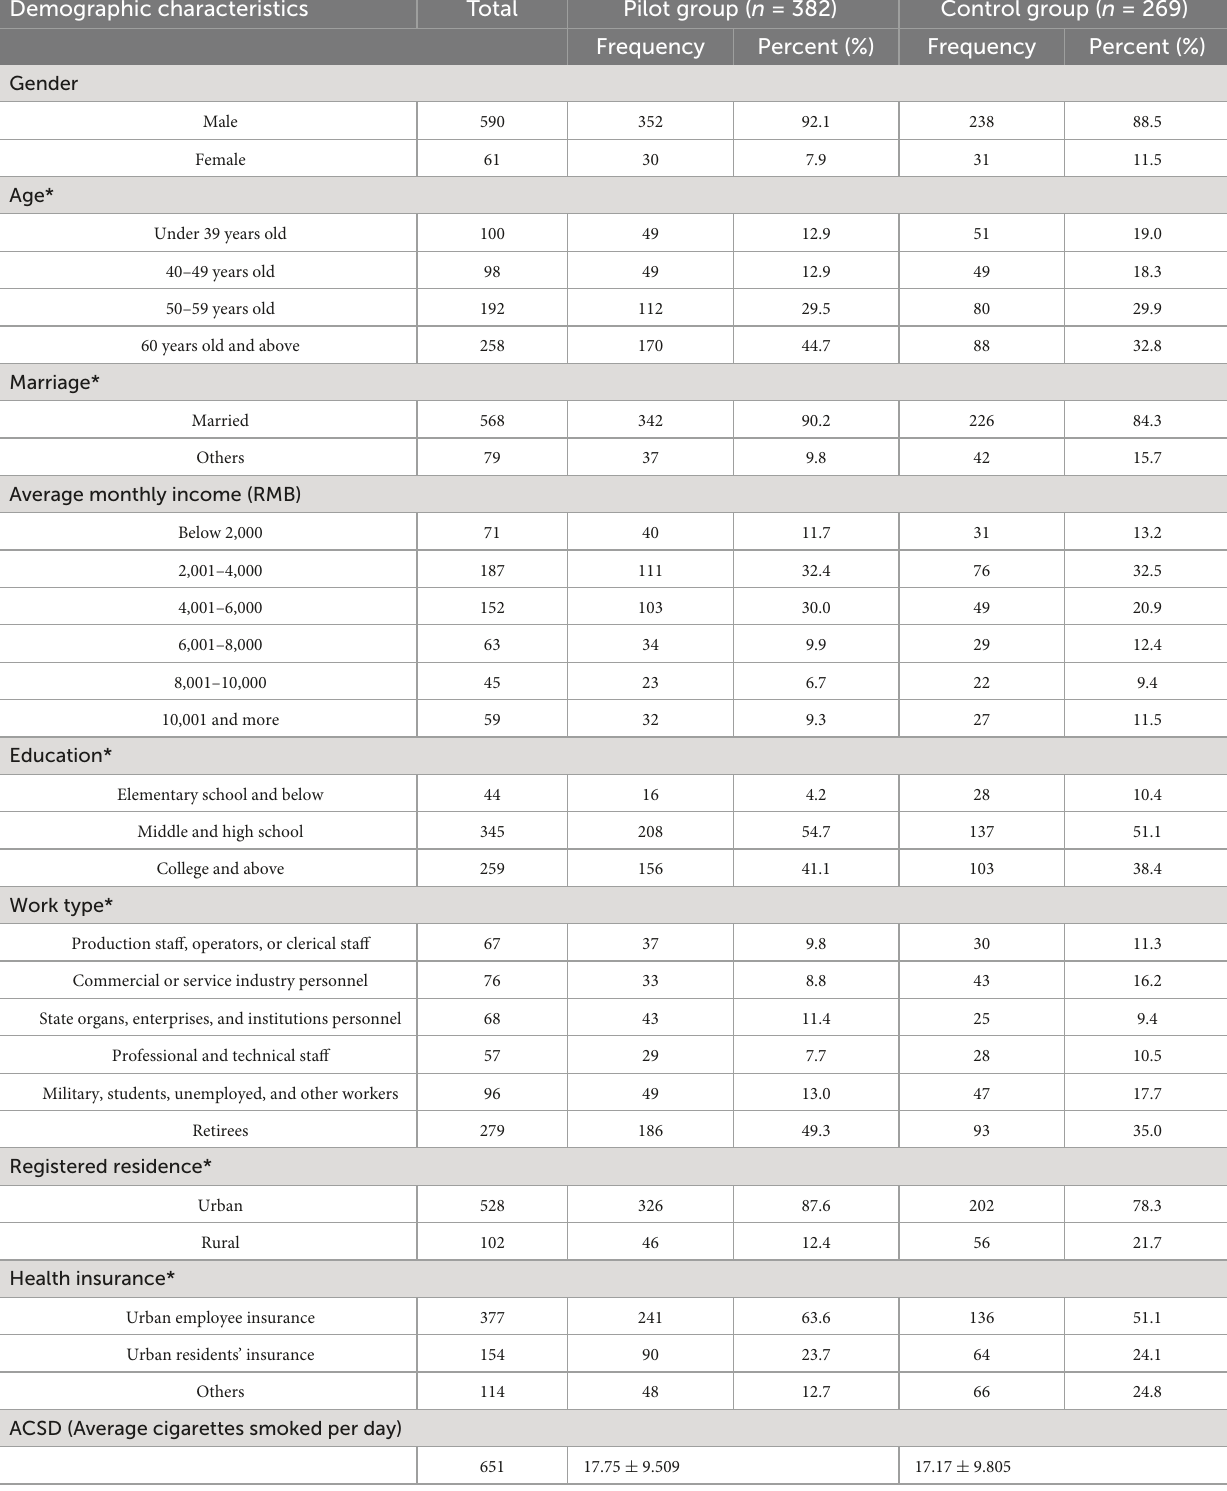
TABLE 2 The demographic characteristics of smokers in study ( N = 651, * P < 0.05). Demographic